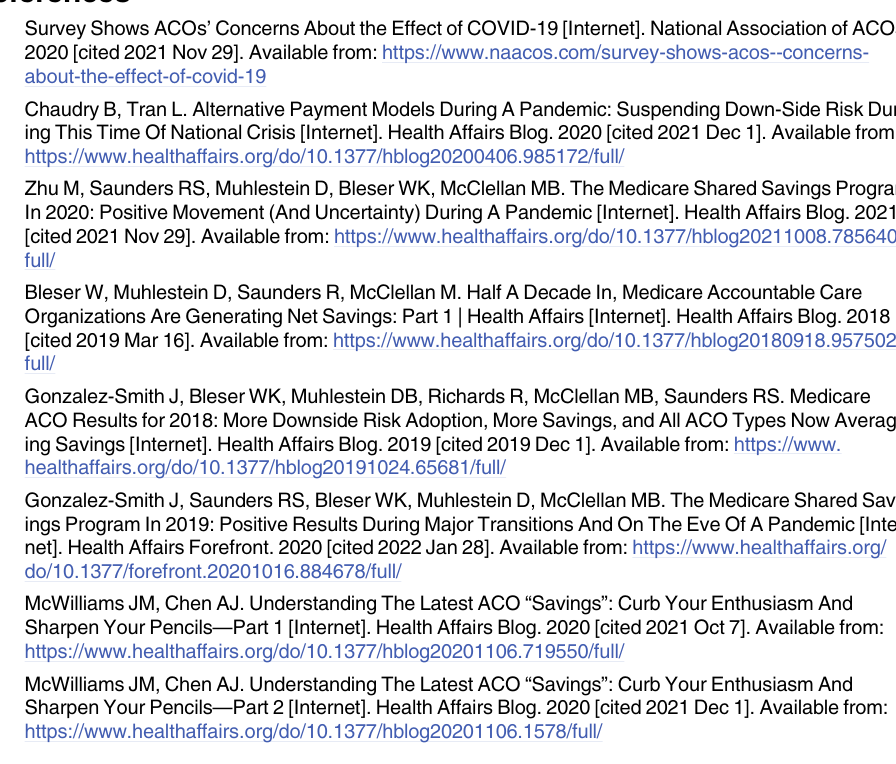
S2 Table. Utilization sensitivity analysis with only ACOs in both 2019 and 2020. S3 Table. Quality sensitivity analysis with only ACOs in both 2019 and